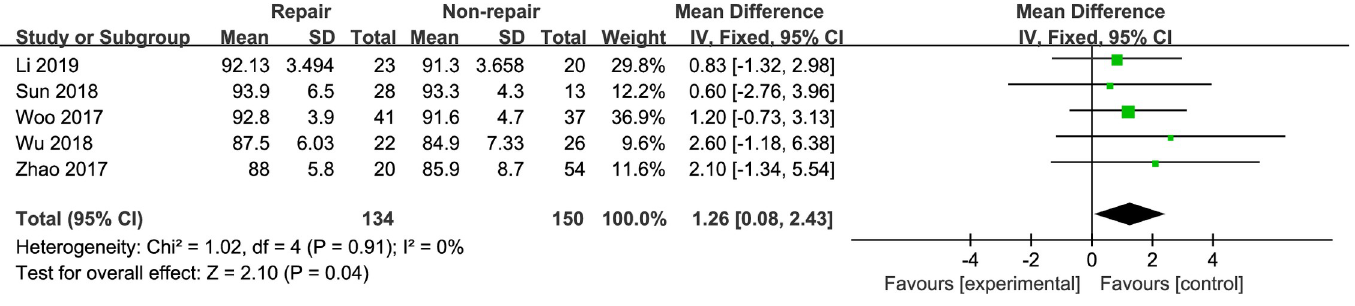
Fig 6. The forest plot of AOFAS ankle-hindfoot